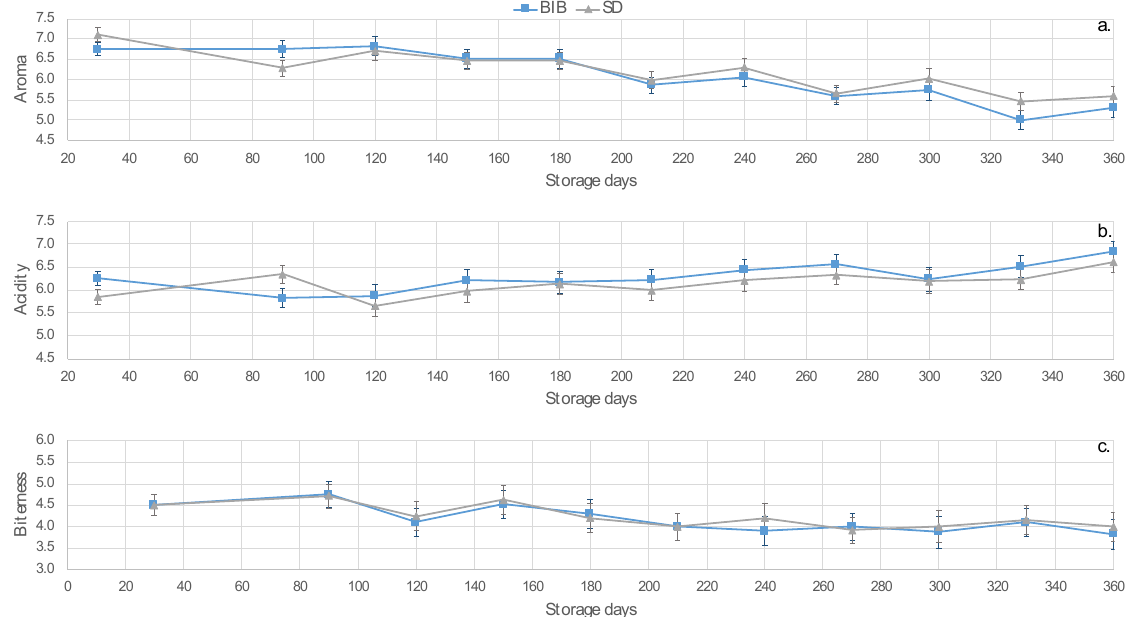
Figure 2. Intensities reported by panel judges ( n = 10). Mean (solid line) and standard error (error bars) showing the changes for aroma ( a ), acidity ( b ), and bitterness ( c ) as a function of the storage time in days. Line color depicts CLC category BIB (blue) and SD (grey).